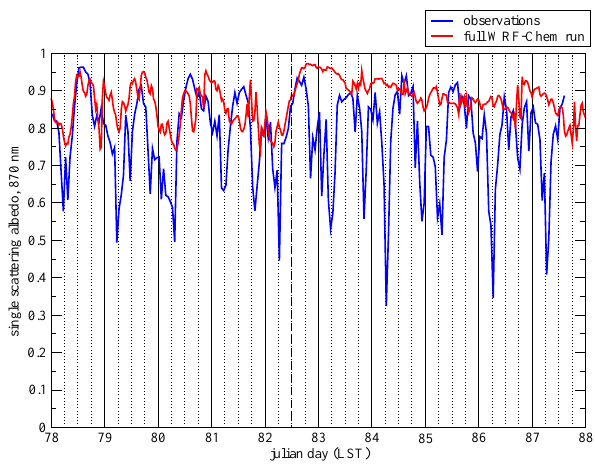
Fig. 1. The solid red line shows the single scattering albedo as calculated by the WRF-Chem model with full prognostic chemistry. The solid blue line represents the observations. (For convenience, we note that day 78 corresponds to 19 March